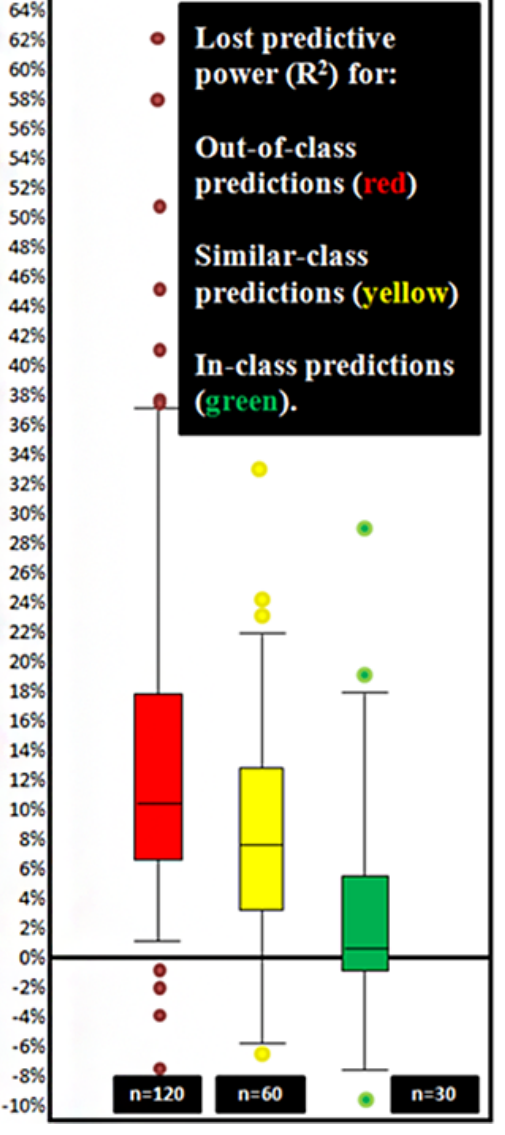
Figure 10. Loss of predictive power ( R 2 ) ( y axis) between base- line predictions (model calibrated in the same watershed) and cross- validation predictions (model calibrated in other watersheds).